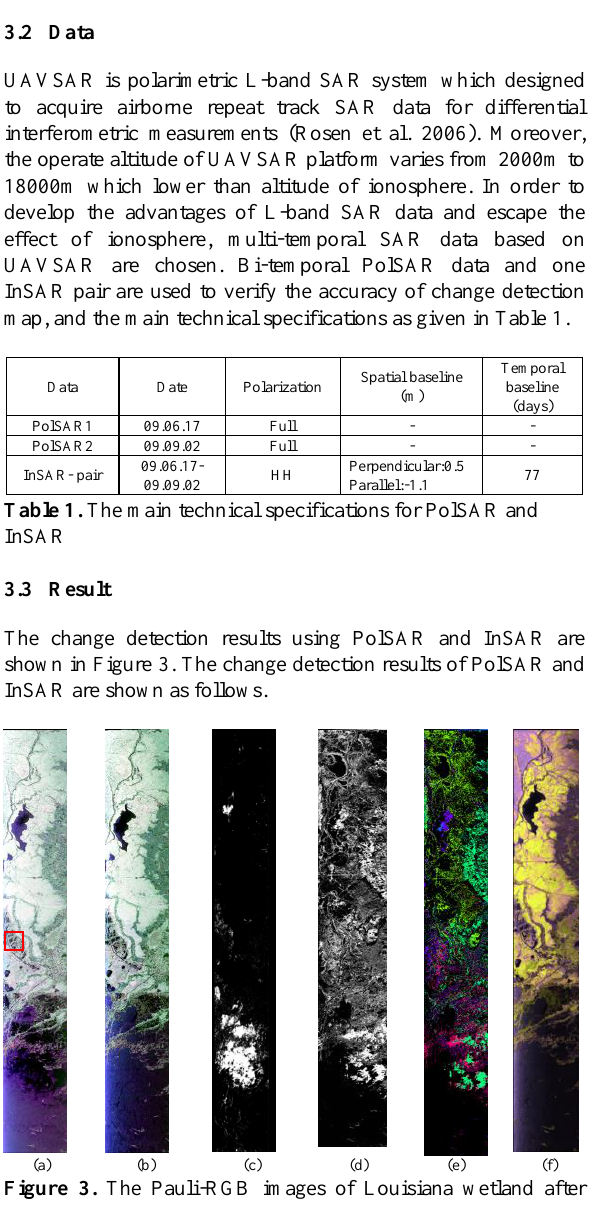
Figure 3. The Pauli-RGB images of Louisiana wetland